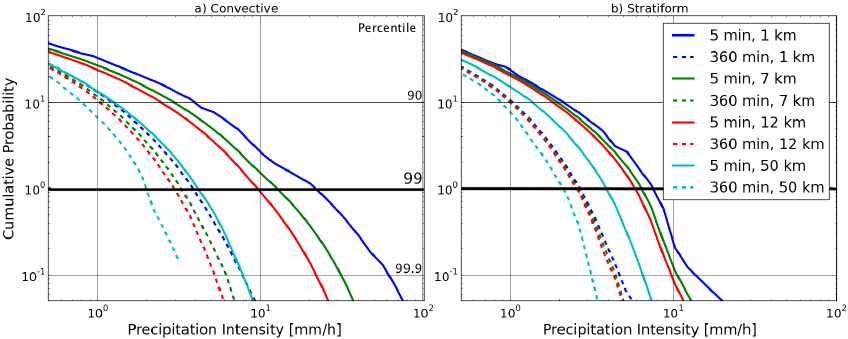
Figure 2. Cumulative probability density functions of precipitation intensities. All of Germany for the years 2007–2008, aggregated at different horizontal and temporal resolutions: (a) convective events and (b) stratiform